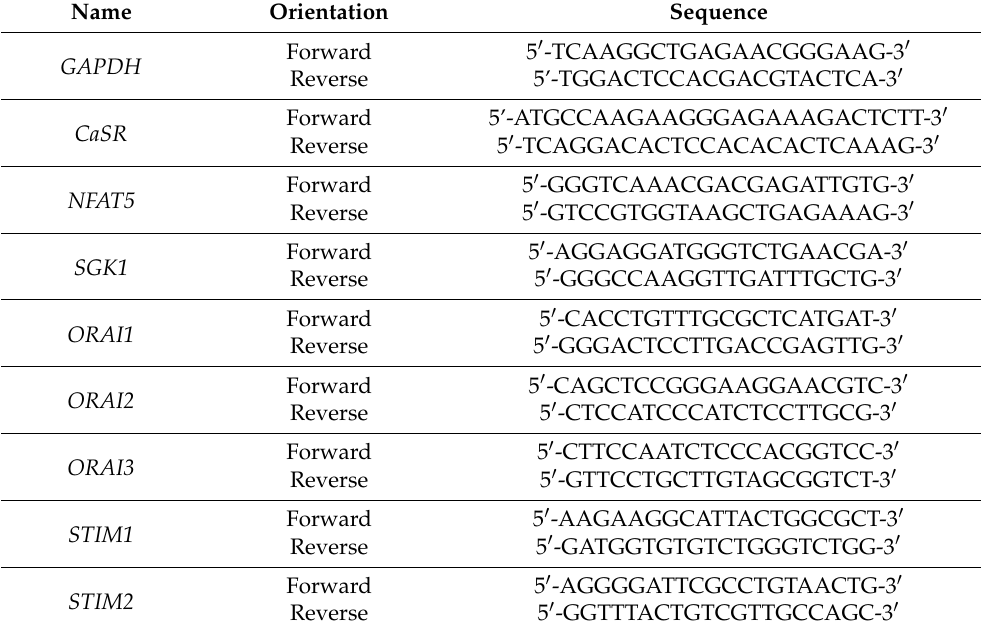
Table 1. List of the primer sequences for